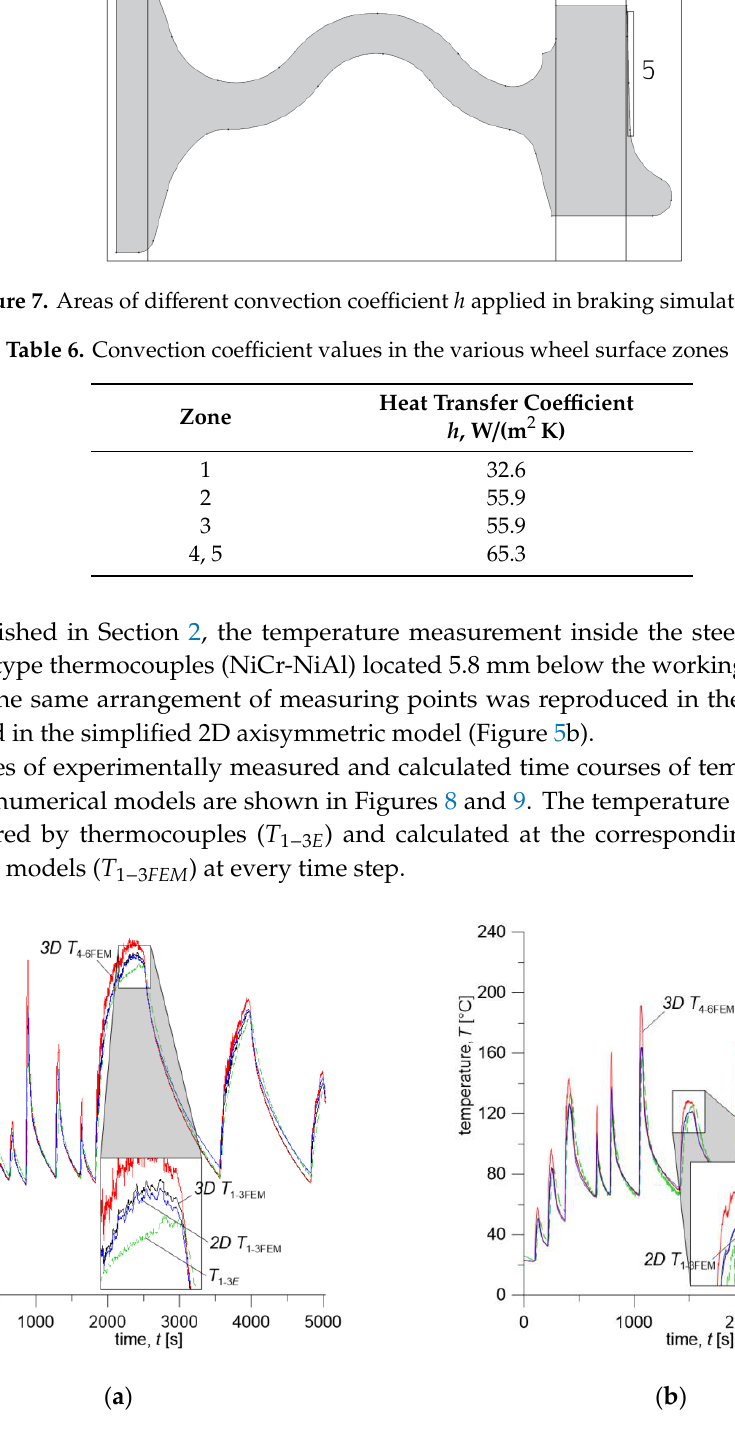
. Table 6. Convection coefficient values in the various wheel surface zones [34]. Zone